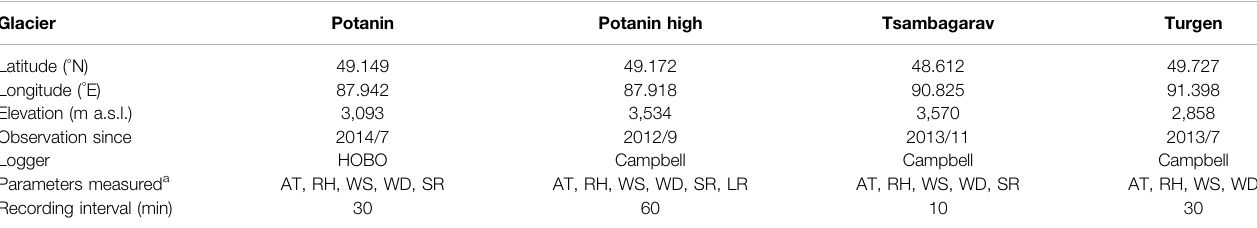
TABLE 2 | Automatic weather stations (AWSs) for three glaciers in this study. AWS for Sutai Glacier was out of work after a short period. Sensor speci fi cations are listed in Supplementary Table S1 . Glacier Potanin Potanin